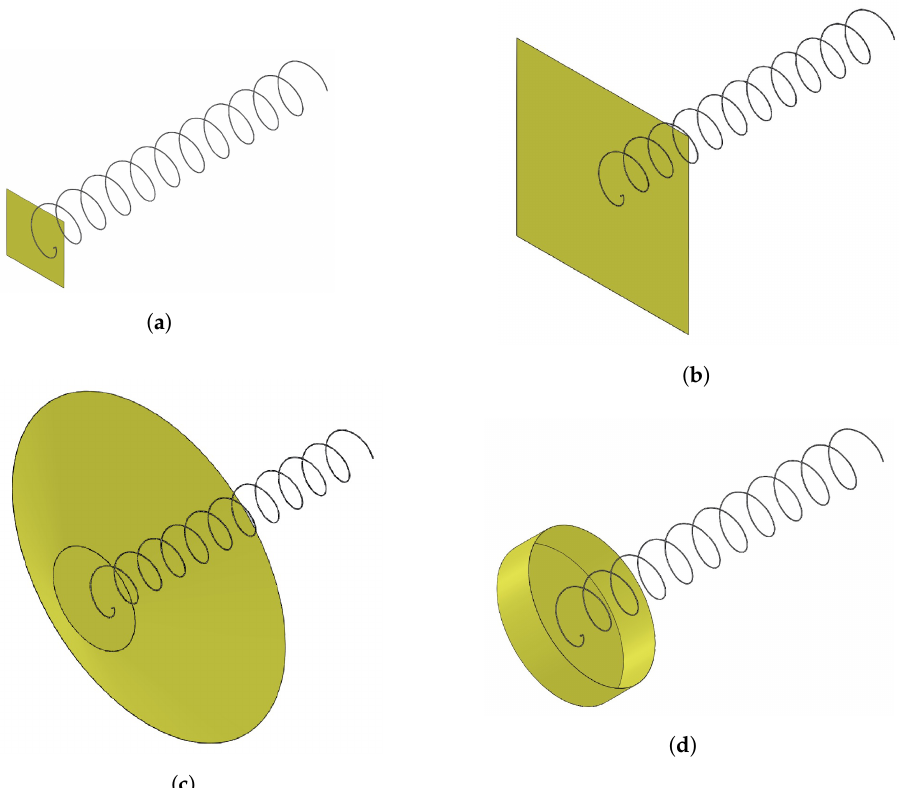
Figure 6. Analysis ground plane models. ( a ) Square model with 0.5 λ GP. ( b ) Square model with 1.5 λ GP. ( c ) Model with conical GP. ( d ) Model with cylindrical GP.